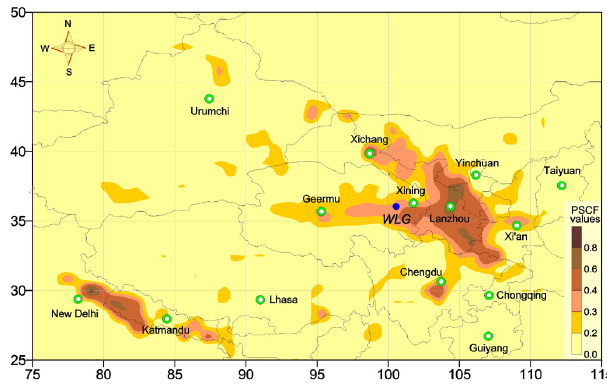
Fig. 6. Likely source areas of TGM identified using Potential Source Contribution Function (PSCF)